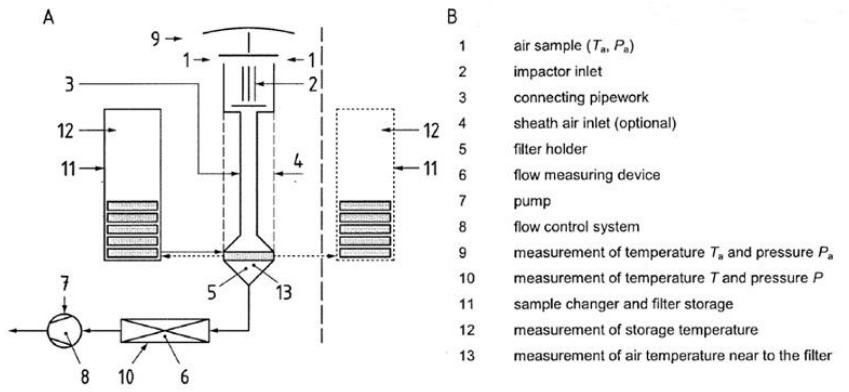
Figure 3. Scheme of PM standard sampler [13].